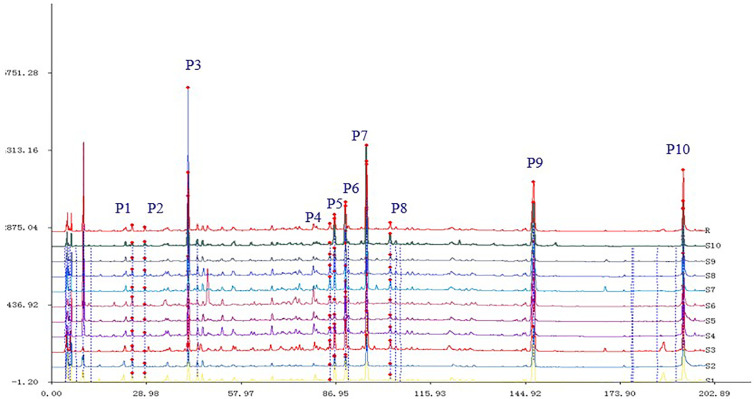
The matching chromatograms characterized by HPLC.